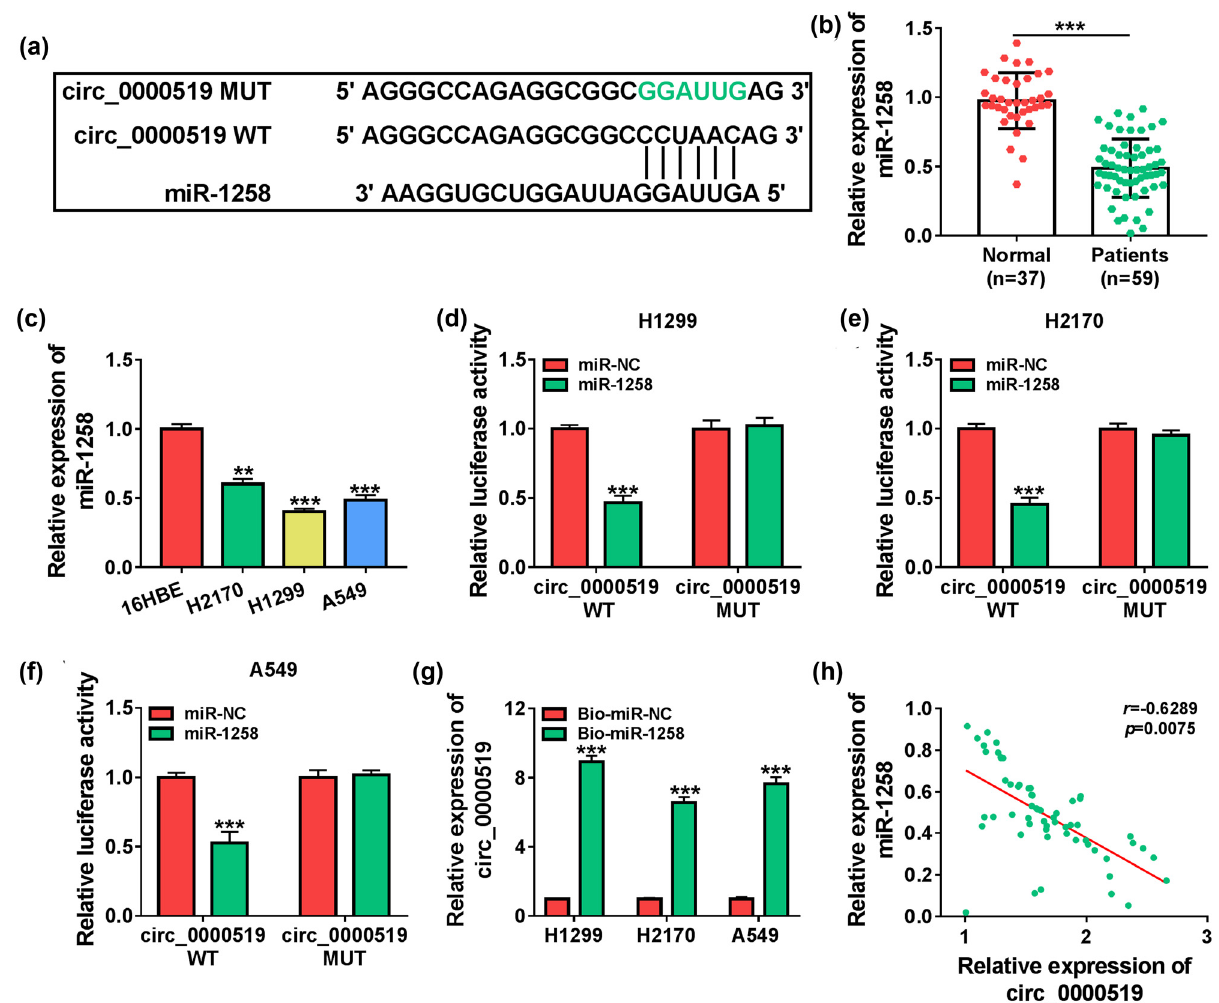
Figure 5: miR - 1258 is sponged by circ_0000519. ( a ) The binding sites of miR - 1258 and circ_0000519 were predicted by circinteractome. ( b ) miR - 1258 expression was examined via qRT - PCR in the serum samples of NSCLC patients ( n = 59 ) or normal subjects ( n = 37 ) . ( c ) miR - 1258 abundance was measured via qRT - PCR in H2170, H1299, A549 and BEAS - 2B cells. ( d – f ) Luciferase activity was detected in the H1299, H2170 and A549 cells transfected with circ_0000519 WT or circ_0000519 MUT and miR - NC or miR - 1258 mimic. ( g ) circ_0000519 level was determined via qRT - PCR in cells after RNA pull - down analysis. ( h ) The linear correlation of miR - 1258 and circ_0000519 levels in NSCLC patients. *** P <